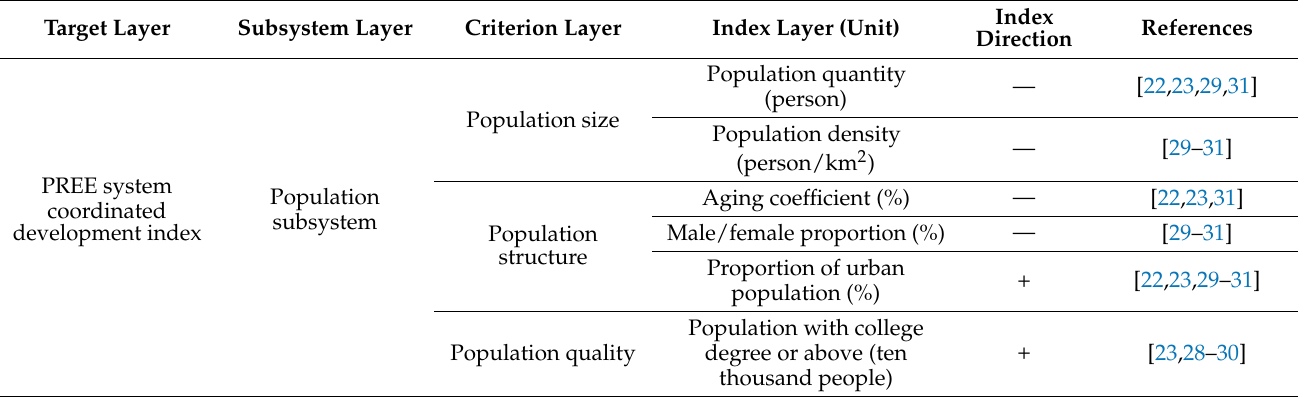
Table 1. Index system of coordinated development of population–economy–resources–environment. Data source: China Statistical Yearbook, China Environmental Statistical Yearbook, China Energy Statistical